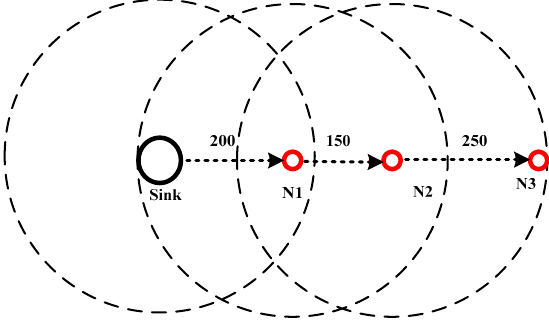
Figure 13. Physical distance calculation in ERP 2 R.